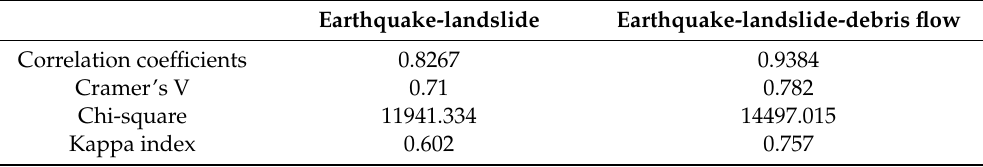
Table 1. The relative analysis results between the series and parallel model and the Bayesian Networks model.